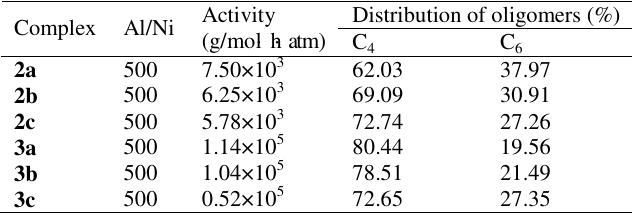
Table 1. Activity and distribution for the